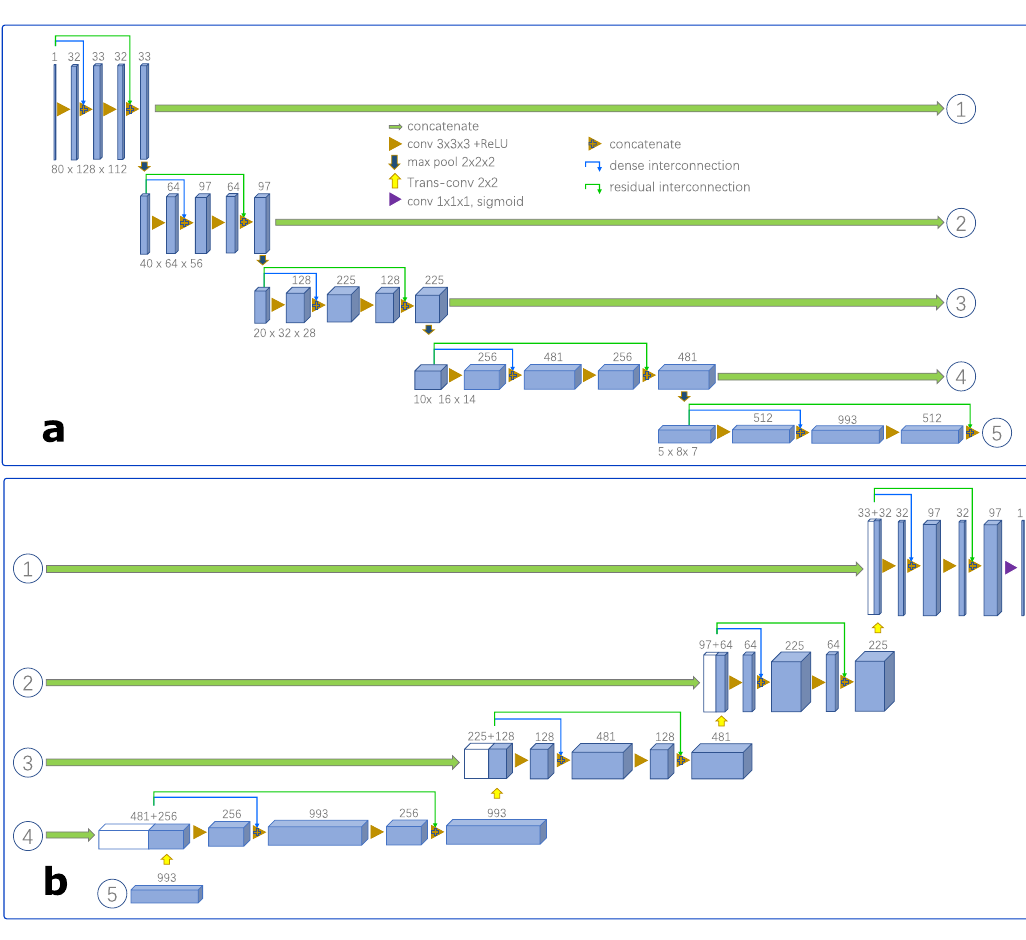
Figure 6. 3D-Dense-U-Net architecture for vertebrae segmentation (Blue boxes represent feature maps. The number of channels is denoted above each feature map. The numbers in the circle from 1 to 5 are joints between ( a ) and ( b )). ( a ), ( b ) The contracting and expansive path of